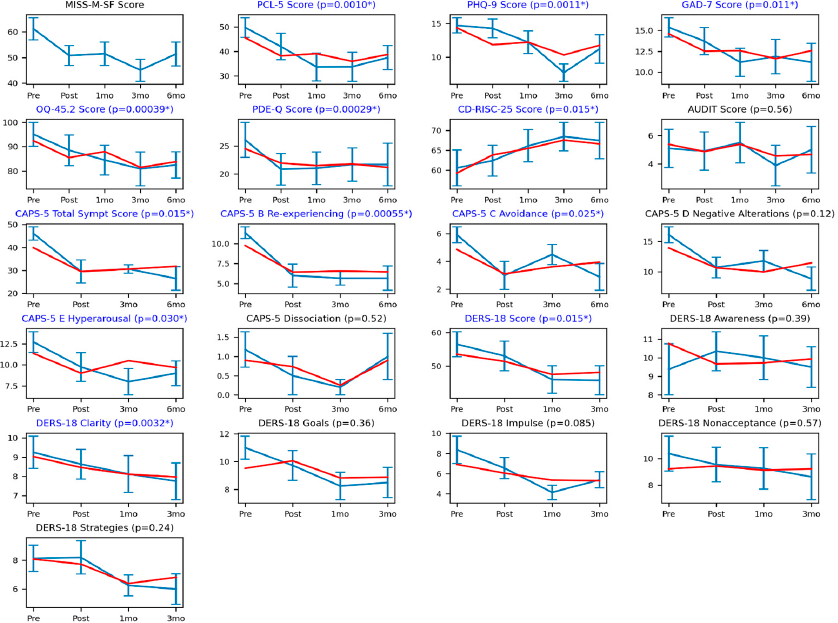
Figure 1. The blue lines show the average scores across the 11 participants at each time point. Error bars indicate the standard error of the mean. The red lines are the estimated scores over time generated from a statistical model that “explained” changes in a given score in terms of the moral injury MISS-M-SF scores. p -values in brackets were generated from these statistical models based on the strength of the relationship between the MISS-M-SF scores and the given score being tested. An asterisk indicates that the p -value was significant and survived FDR multiple comparison correction (the p -value threshold was computed to be 0.030). In addition, graphs for which the p -value was significant and survived multiple comparison corrections have a blue title (as opposed to the black title for non-significant results).